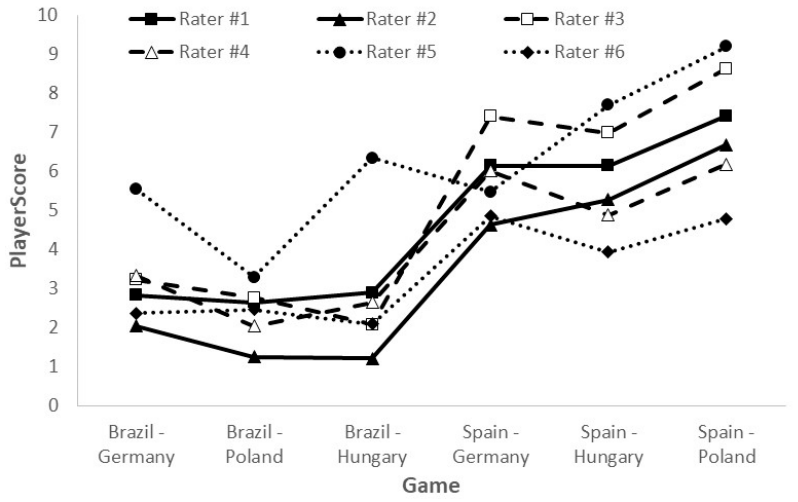
Figure 4. PlayerScore team performance (mean values) separated by raters and games.